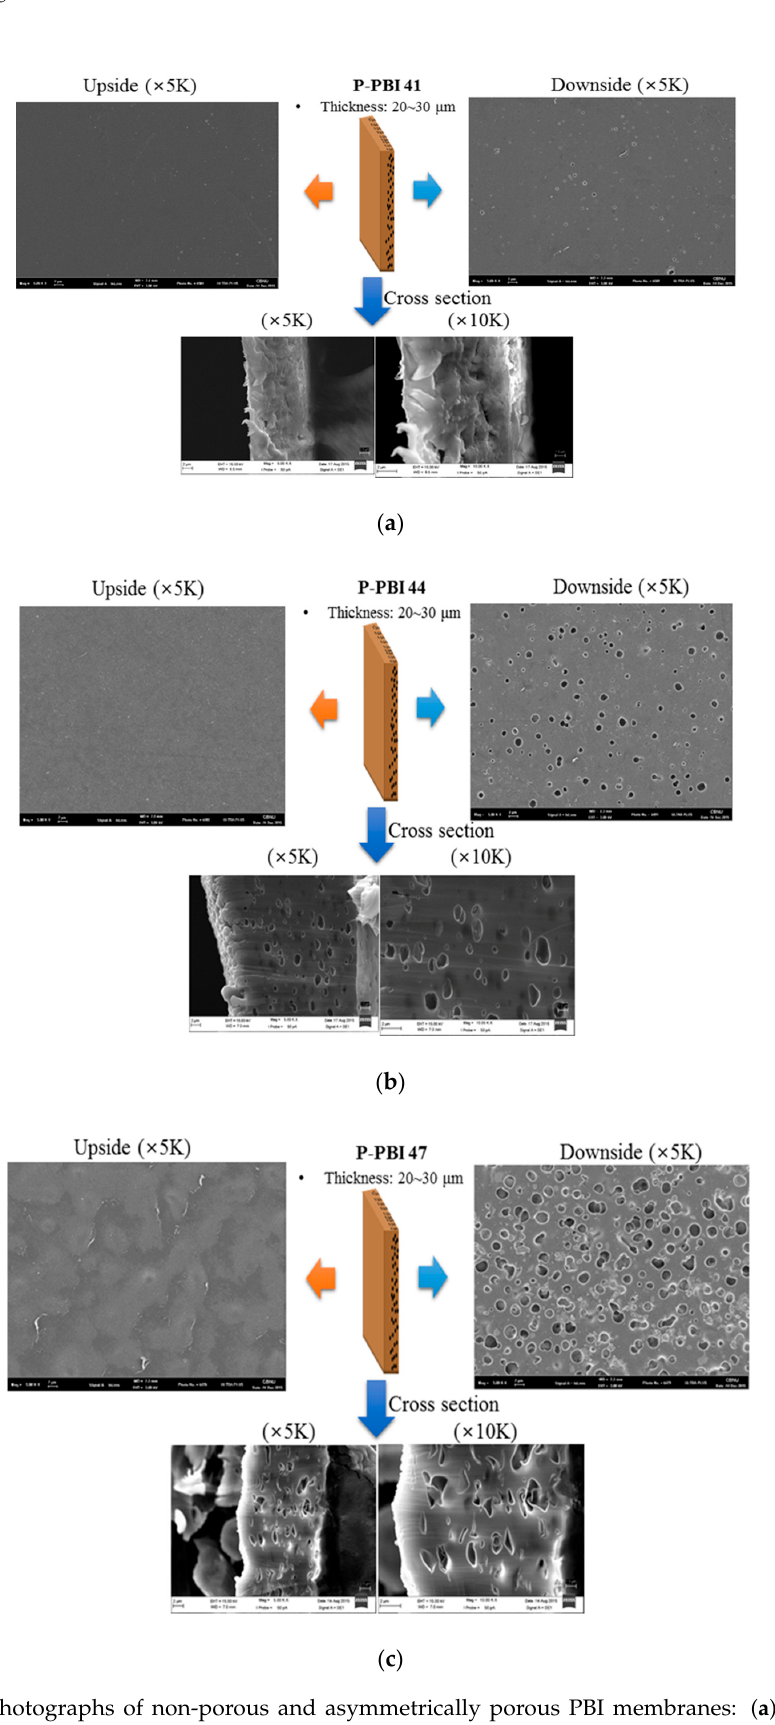
Figure 3. Photographs of non-porous and asymmetrically porous PBI membranes: ( a ) P-PBI 41, ( b ) P-PBI 44 and ( c ) P-PBI 47.